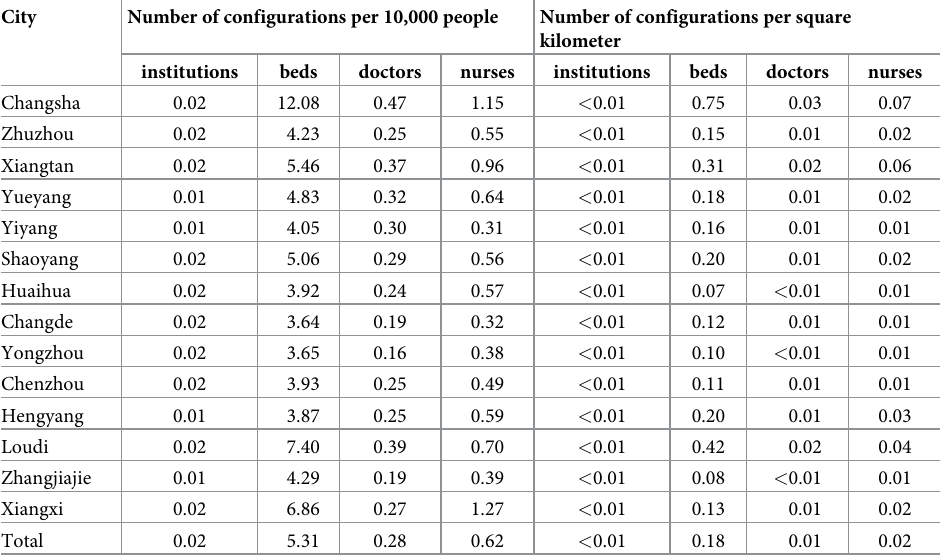
Table 4. Equity allocation of mental health resources according to population and geographical areas.